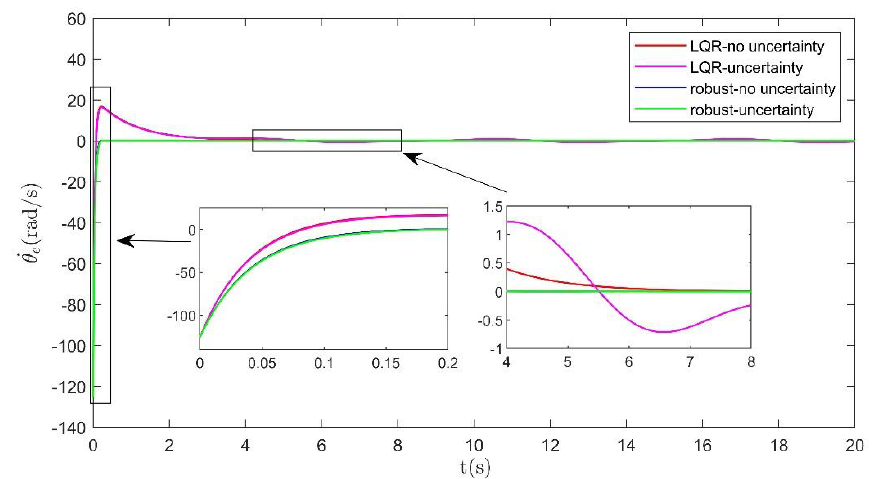
Figure 10. The step tracking speed error curve with uncertainty or not.